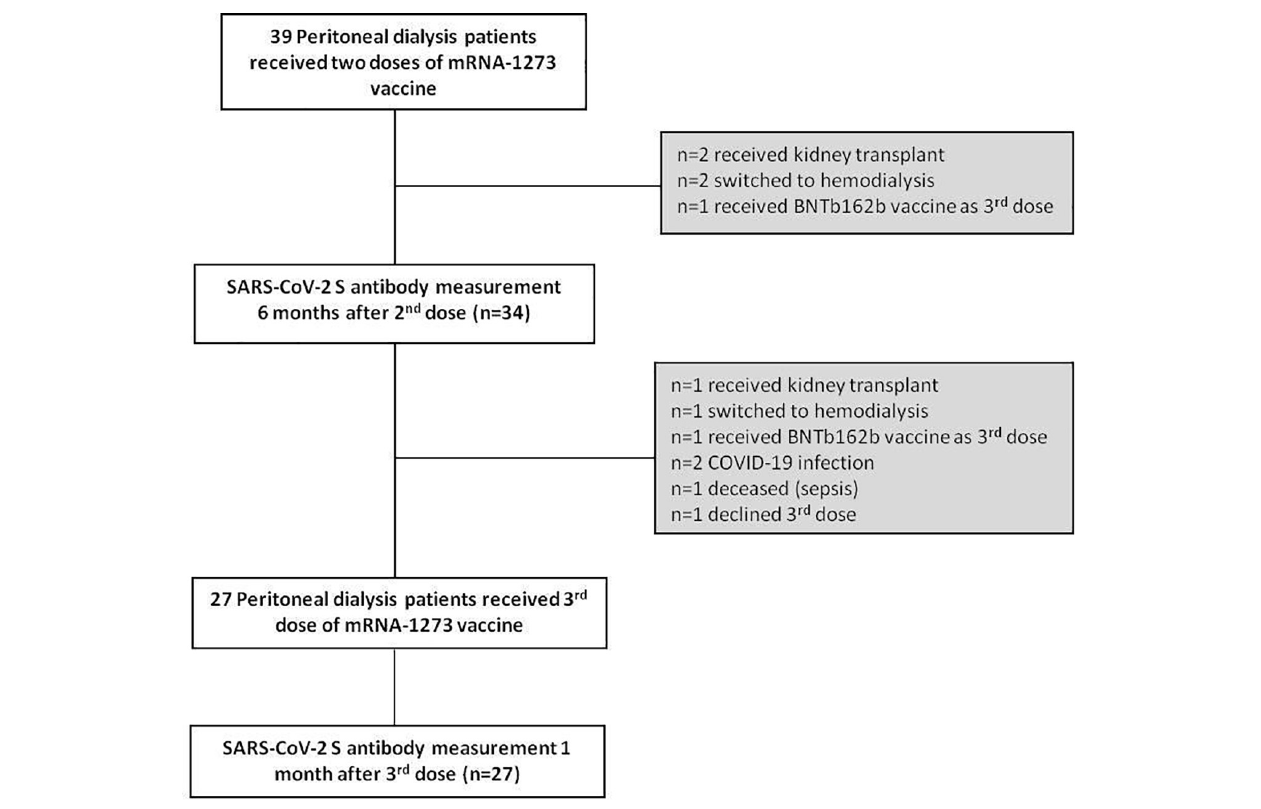
FIGURE 1 | Study flowchart of the peritoneal dialysis patient